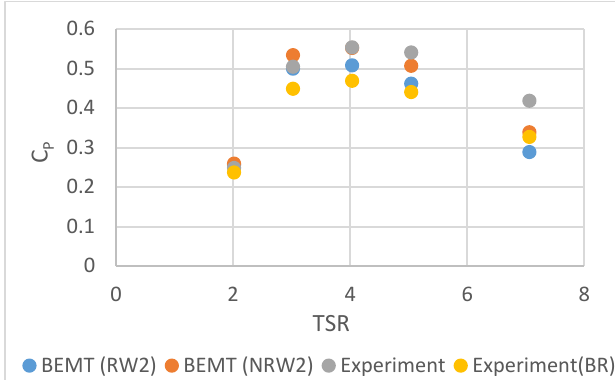
Figure 11. C P comparison between BEMT calculations and experimental data for the inflow profiles with and without a turbine when the turbine operates under wave-current interactions with a wave height of approximately 0.09m and an apparent wave period of 0.5s.